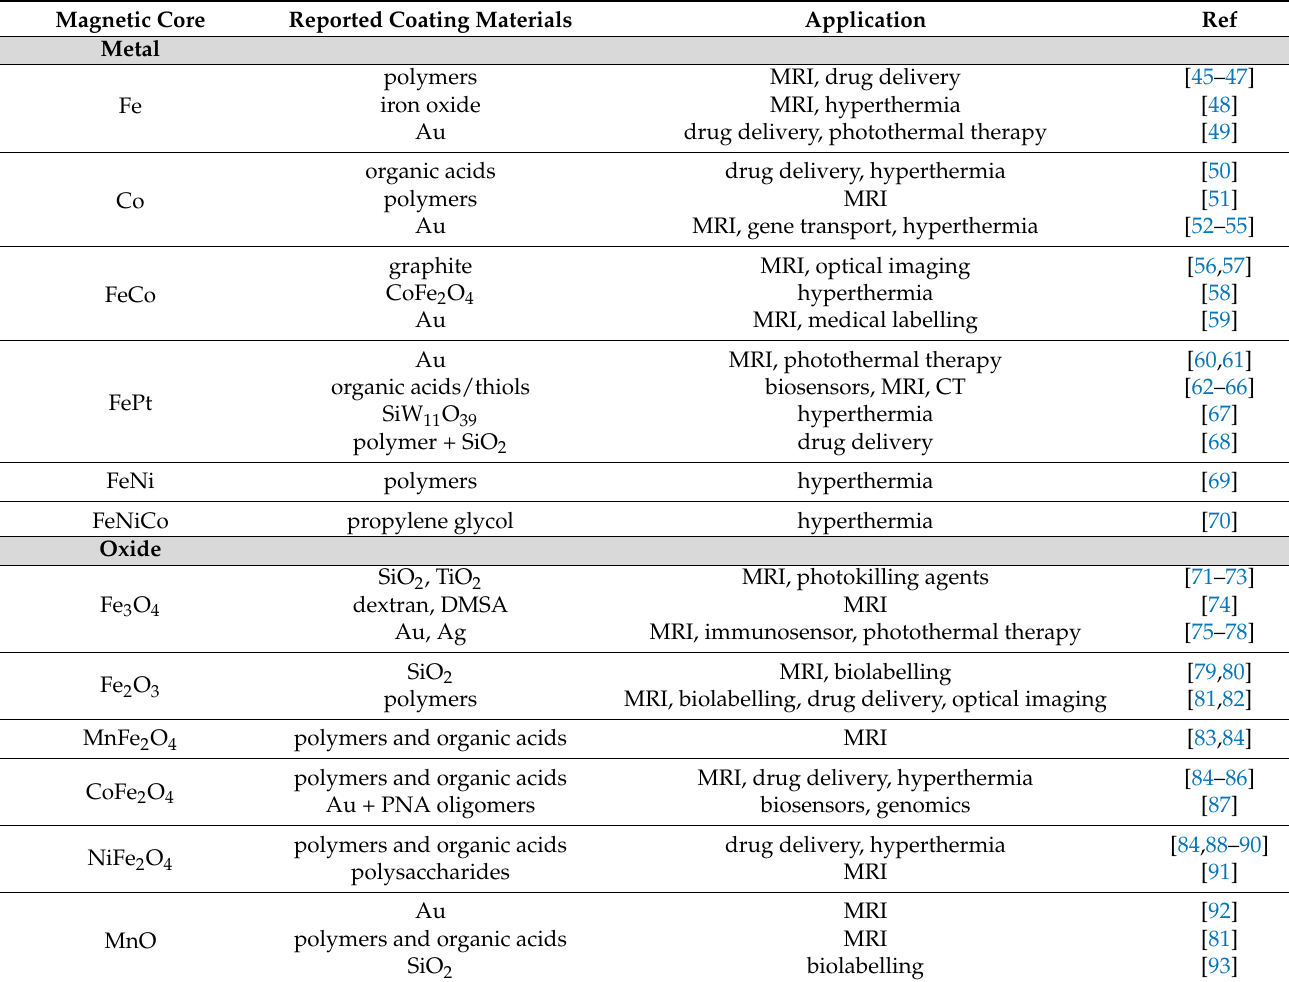
Table 1. Classification of magnetic NPs based on the core and coating materials and their respective applications. Magnetic